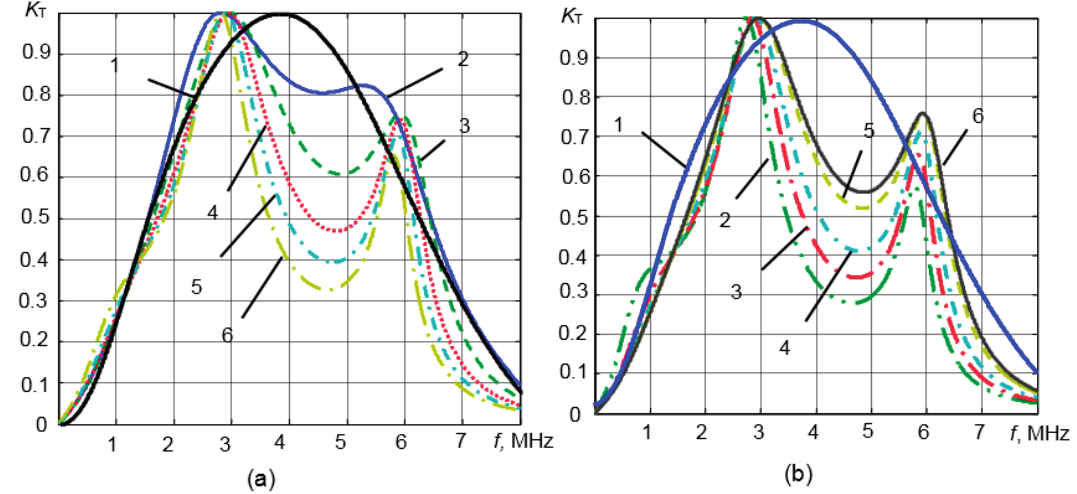
Figure 6. The mathematical model of the piezoelectric transducer with waveguide. Acoustic impedances of the elements: Z d , damping; Z 0 , piezo element; Z 1 , adhesive layer; Z 2 , waveguide; Z 3 , matching layer; Z 4 , measured medium; Z 1G , 2G , electrical impedances. The influence of the adhesive layer acoustic impedance and thickness on the transducer frequency response is presented in Figure 7a,b. It was assumed that the multi-layered piezoelectric transducer with the steel waveguide is loaded by the liquid acoustic impedance, which is Z 4 = 1.8 MRayl. The resonance frequency of the piezoelectric element was 3.3 MHz. The frequency response of a single-layer piezoelectric element without the adhesive layer is presented in Figure 7a,b by Curve 1. K Tnorm ( f ) = K T ( f )/ K max ( f ) is the normalized transfer function of the multi-layered transducer in the transmission mode; K T ( f ) = p ( f )/ U in ( f ), p ( f ) is the acoustic pressure in the measured liquid; U in ( f ) is the electric voltage at the input of the piezoelectric element; and K max ( f ) is the maximal value of the transfer function.